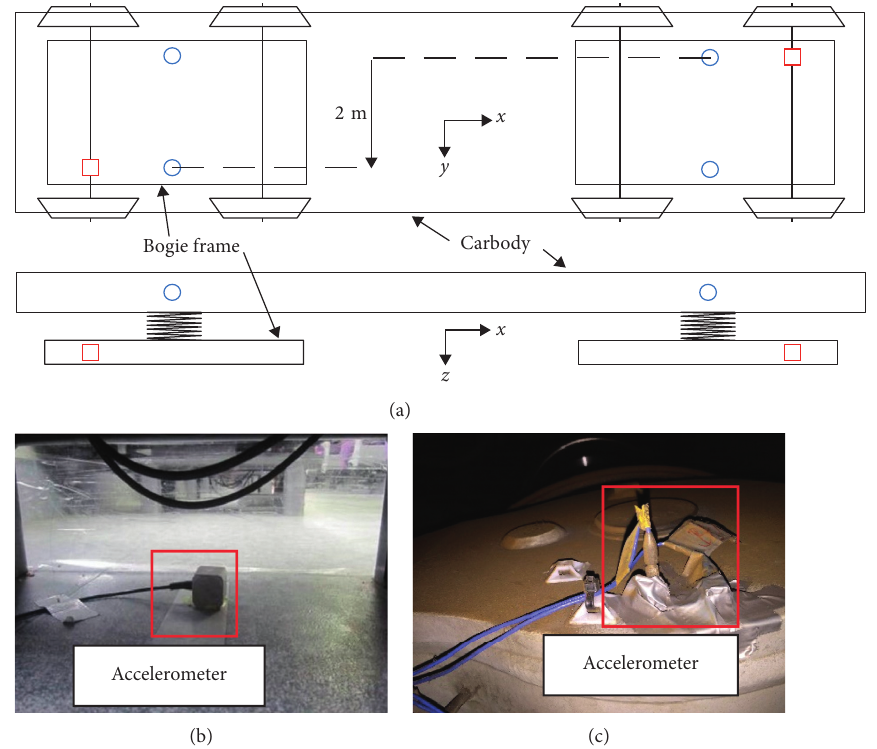
Figure 1: (a) Sensor location (red boxes and blue circle represent the accelerometers on the bogie frame and carbody floor, respectively); and the field test photos. (b) Accelerometer on the carbody floor. (c) Bogie